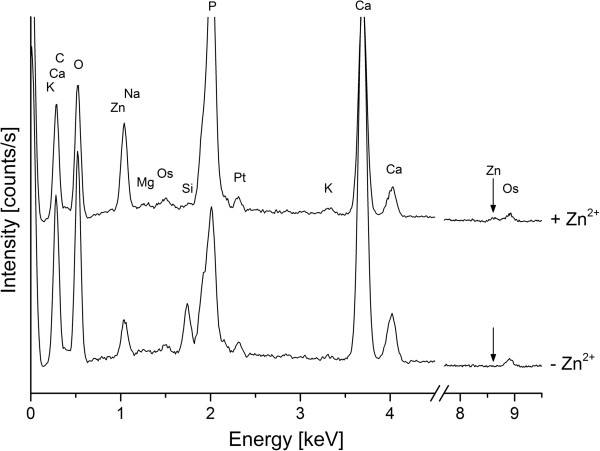
Elemental analysis of bacteria cells and the mineralized inorganic phase by EDX spectroscopy. For both culture media calcium accumulated to high levels, reflecting the formation of calcium carbonate. In medium with zinc acetate supplementation (upper spectrum, + Zn2+) additional zinc peaks were detected compared to the one without zinc (− Zn2+). The detection of osmium and platinum is due to the subject of sample preparation and staining. The silicon peak originates form the silicon wafer which was used as sample holder.